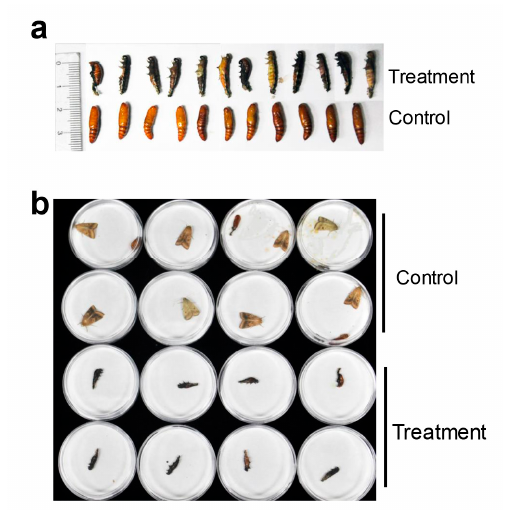
Figure 5. Developmental deformity phenotype of H. armigera at the pupal and emergence stage. ( a ) The inhibition of pupation of 5th-instar larvae after feeding with transgenic cotton expressing HaHR3 ; ( b ) the deformity of adult emergence. The control group was fed with male parent F15 cotton; treatment groups were fed with transgenic cotton.